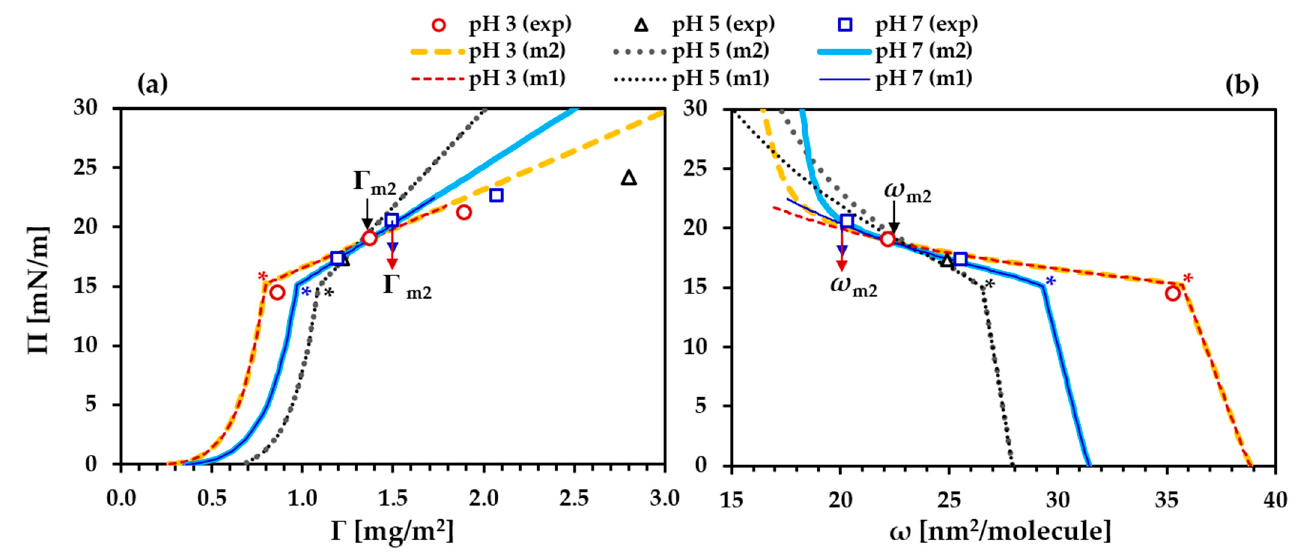
Figure 2. BLG adsorption layers at the water/air interface at different bulk pH. ( a ) Equations of state Π ( Γ ). ( b ) Π ( ω ) dependencies in analogy with the compression isotherms for spread layers. Asterisks indicate Π *, Γ * and ω *, and arrows indicate the onset of the secondary layer